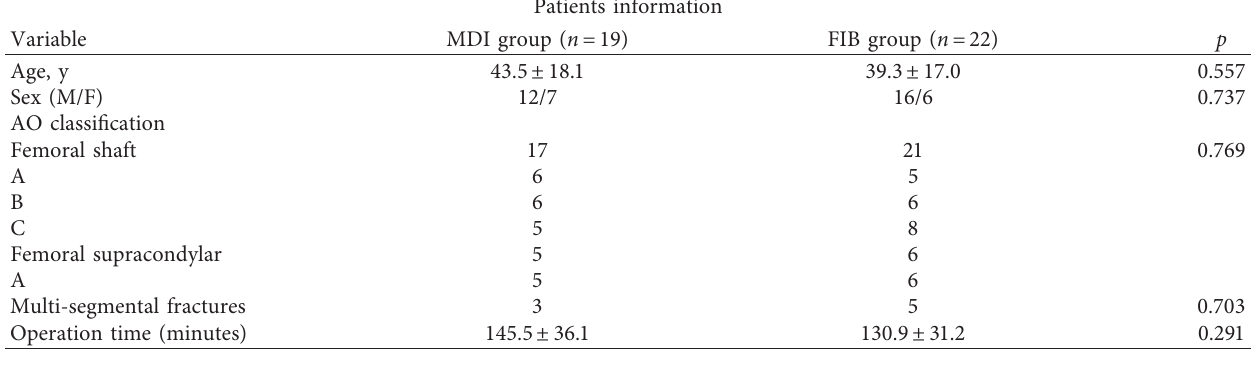
Table 1: Patients information.